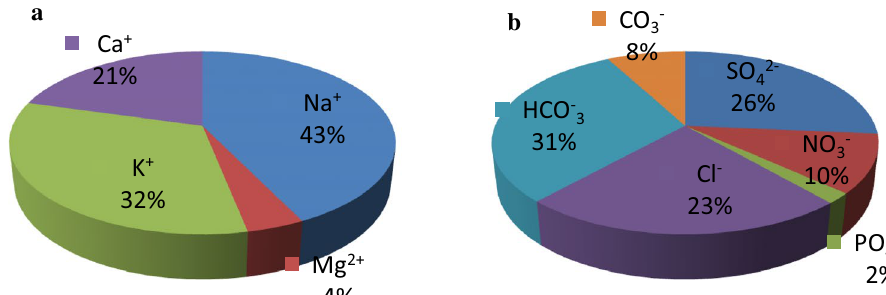
Fig. 2 Contribution of cations ( a ) and anions ( b ) to the total cationic and anionic